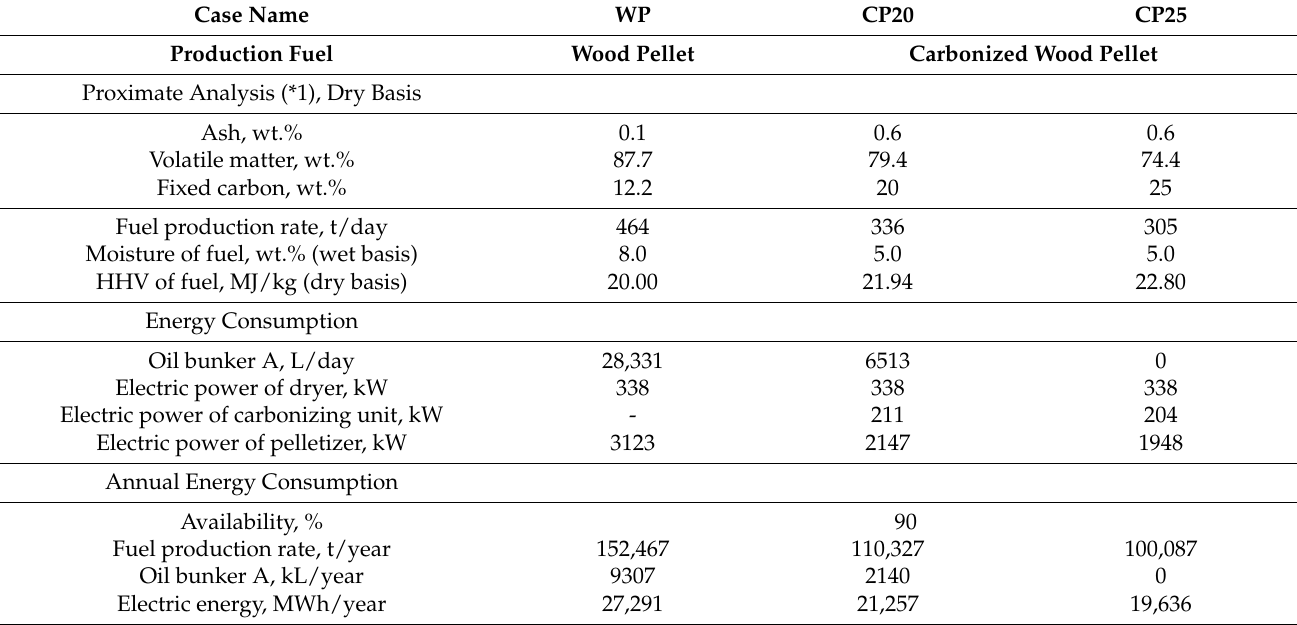
Table 4. Estimation of energy consumption during the fuel production of WP and CP.